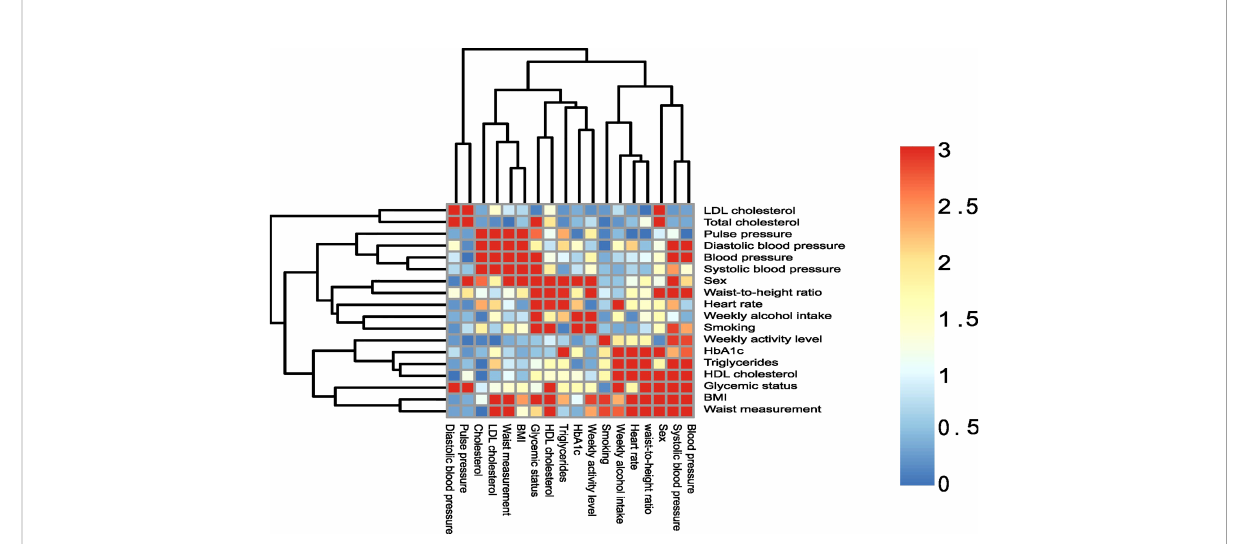
FIGURE 1 Association of sample variables. Heatmap of sample variables compared by chi-squared tests. The p-values are visualized on a log scale (-log10 (pvalue)). A value of 1.30 represent a 0.05 signi fi cance cut-off, and values above 1.30 are considered statistically signi fi